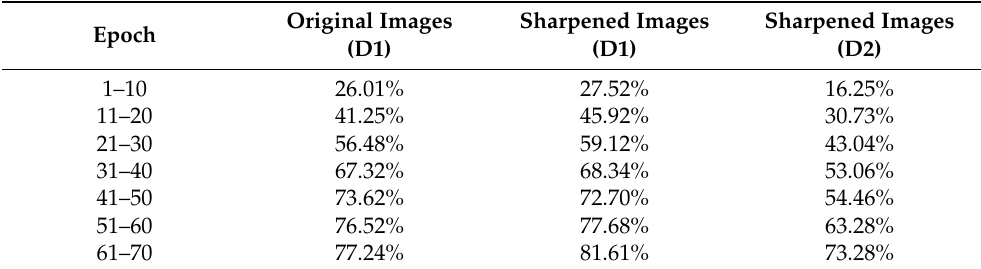
Table 3. Results for original and sharpened images (the latter for both D1 and D2)—averaged accuracy for the range of training epochs.